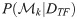
Summary of the results from the two model selection rounds.(a) Logarithm of the model posterior probabilities obtained from averaging the outcomes of three runs of the SMC algorithm using the GATA TF mRNA data, under a uniform model prior. The results of individual runs are reported in Section 5.3 of S1 Text. Models missing the interaction of hypothesis 4 are clearly ranked lower than the rest (b) Logarithm of model posterior probabilities for the 16 models considered in the second model selection round. The numbers reported were obtained for each model by averaging over all possible products of estimates of P(Mk|DTF) and two estimates of F(Dtargets,Mk). Models 35 and 135 clearly stand out, as their posterior probabilities are distinctively greater than the rest, with 90% confidence intervals (computed from the data presented on Table G in S1 Text) equal to 0.23±0.11 and 0.77±0.35 respectively. Note that all models missing interaction 2 are ranked lower.